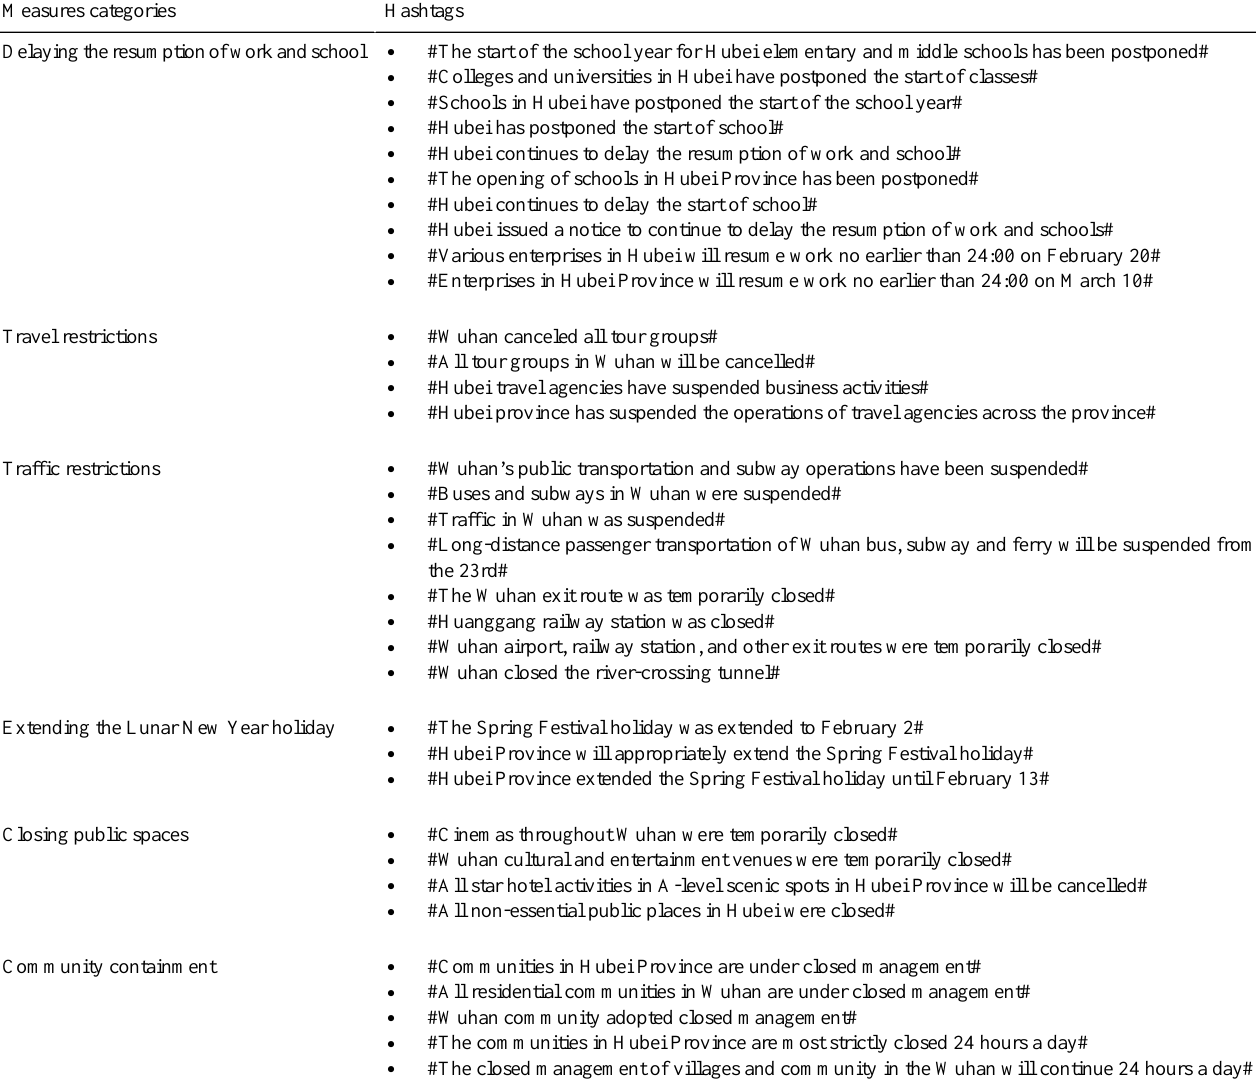
Table 1. Hashtags on social distancing measures related to COVID-19 on Sina